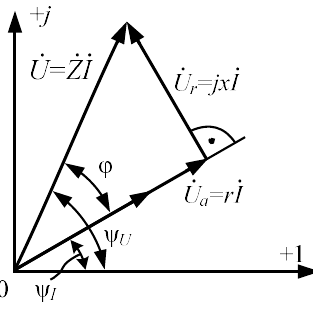
Figure 4. Voltages, a vector diagram.